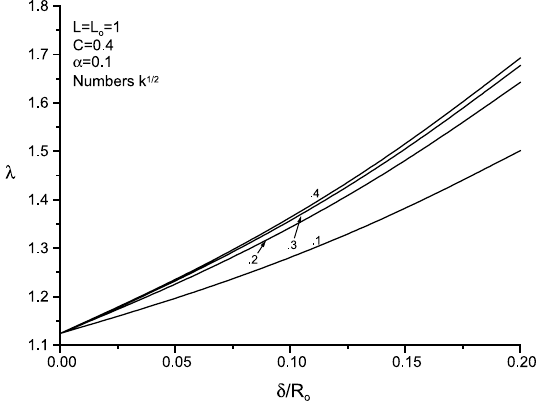
Fig.3. Impedance, λ versusstenosisheight, δ/ R o fordifferentDarcy number, k 1 / 2 . 1, 2, 5; C = 0, 0.2, 0.4, 0.6; α = 0.1, 0.2, 0.3, 0.4, 0.5; √